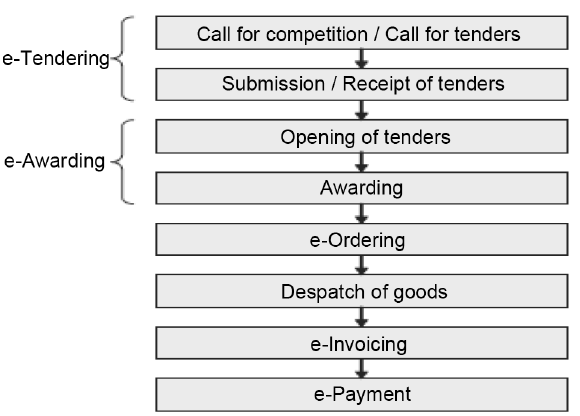
Fig. 2. Reference E-procurement process (Grilo, Jardim- Goncalves